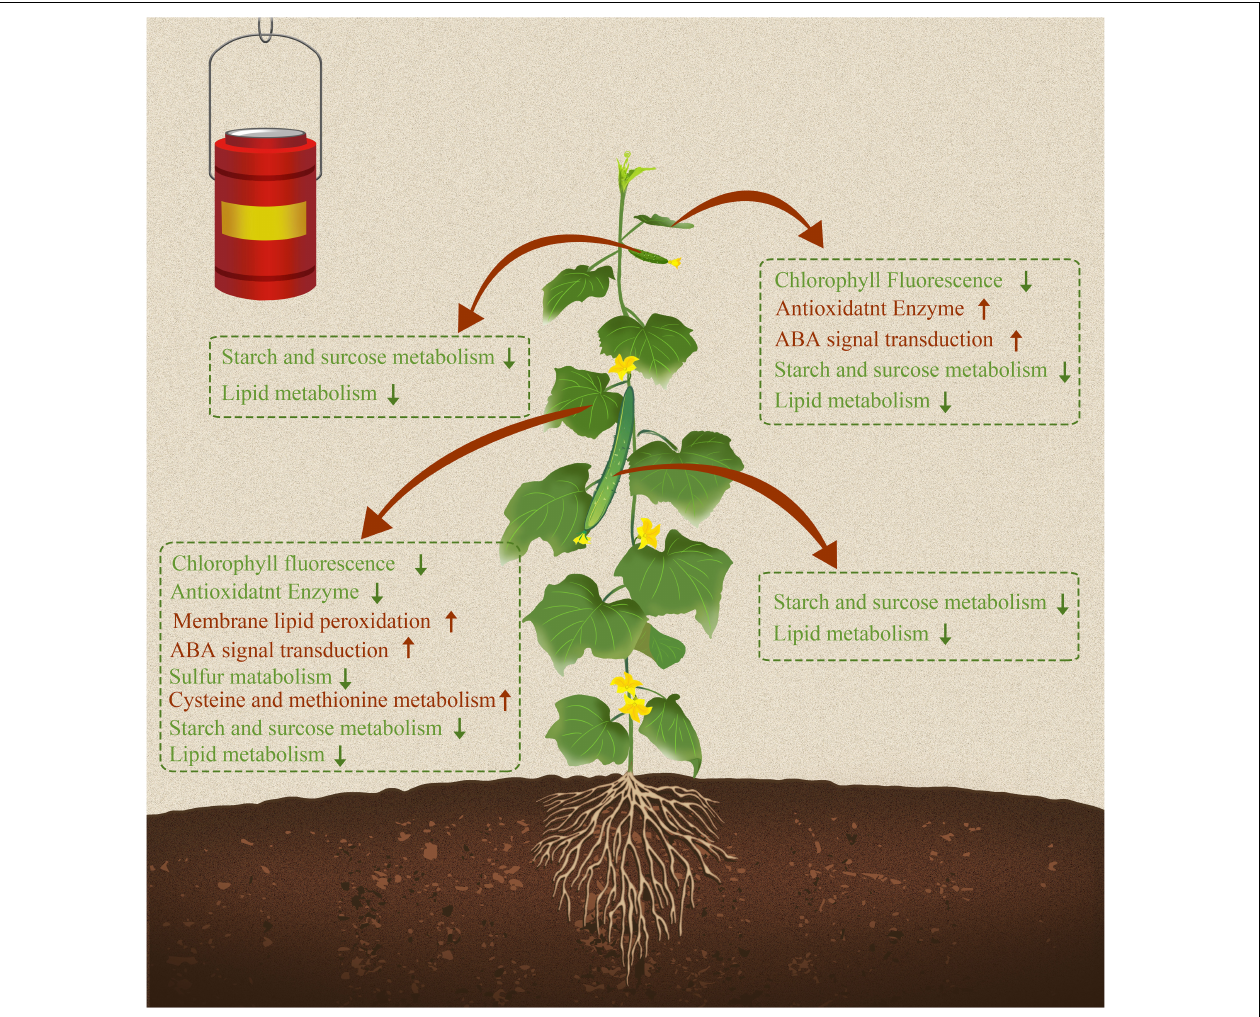
FIGURE 10 | Sulfur fumigation modulated growth, transcription expression profiles, and metabolic pathways in cucumber leaves and fruits. Red and green arrows represent upregulated and downregulated physiological indicators, transcriptional regulation pathways, and metabolic pathways due to S